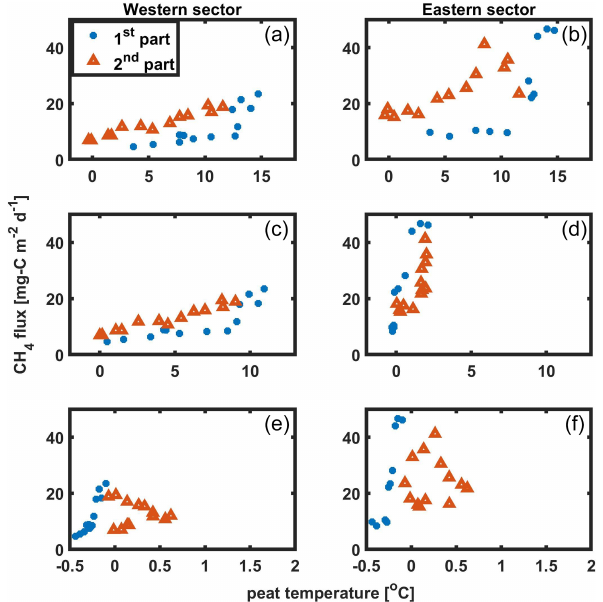
Figure 6. Weekly averages of CH 4 fluxes against the surface peat temperature (a, b) , the depth with best correlation (c, d) , and the deeper layer (e, f) . Data were divided into the first part of the grow- ing season (blue dots) before the maximum weekly emission and the second part of the growing season (orange triangles) after